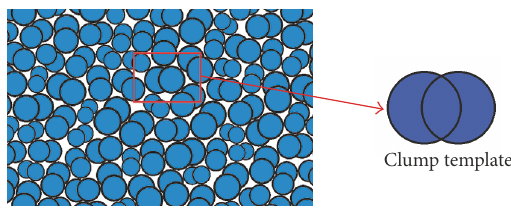
Figure 17: Clump model and clump template.